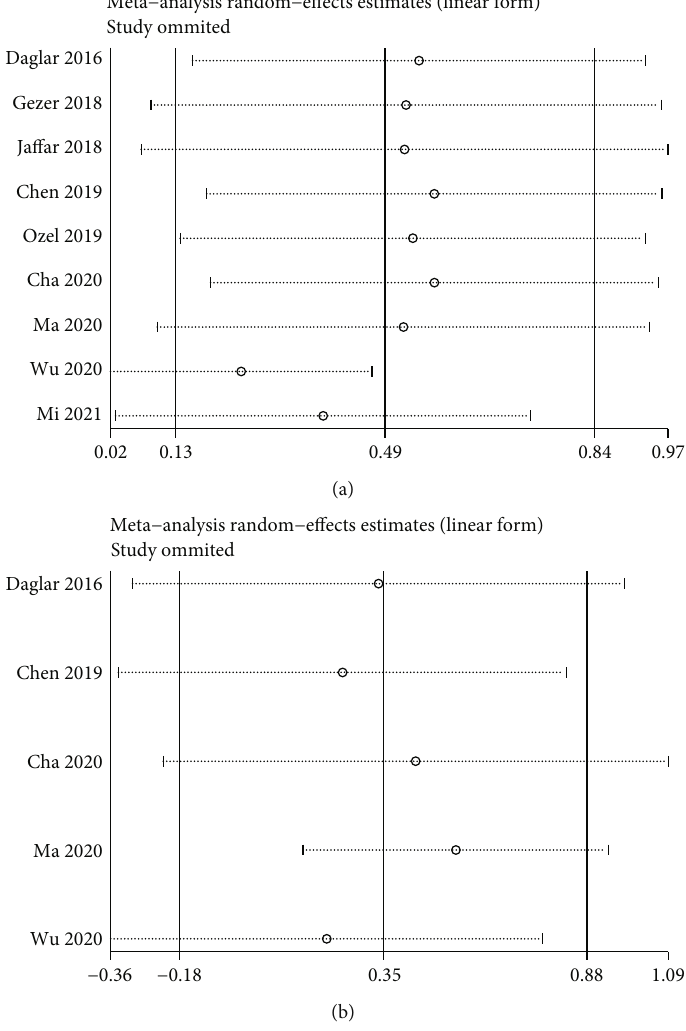
Figure 5: Sensitivity analysis. (a) Sensitivity analysis of PLR. (b) Sensitivity analysis of